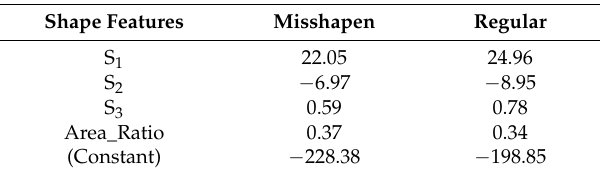
Table 5. Classification functions coefficient derives from the discriminant model for predicting mango shape.